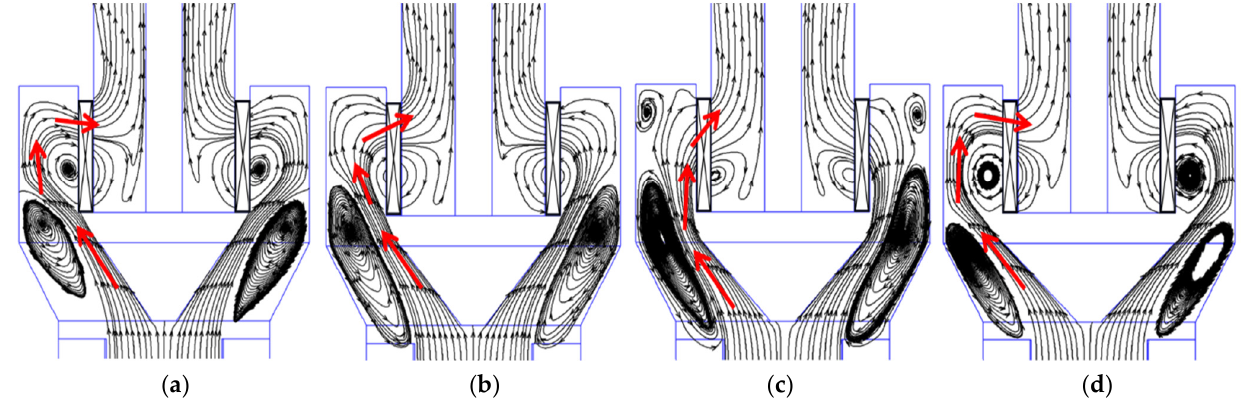
Figure 11. Effect of the guide cone diameter on airflow movement: ( a ) D = 196 mm, ( b ) D = 216 mm, ( c ) D = 236 mm, ( d ) D = 256 mm.